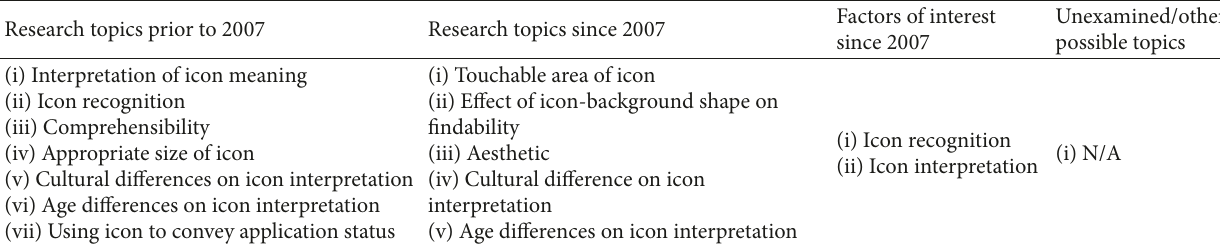
Table 11: Icon research.